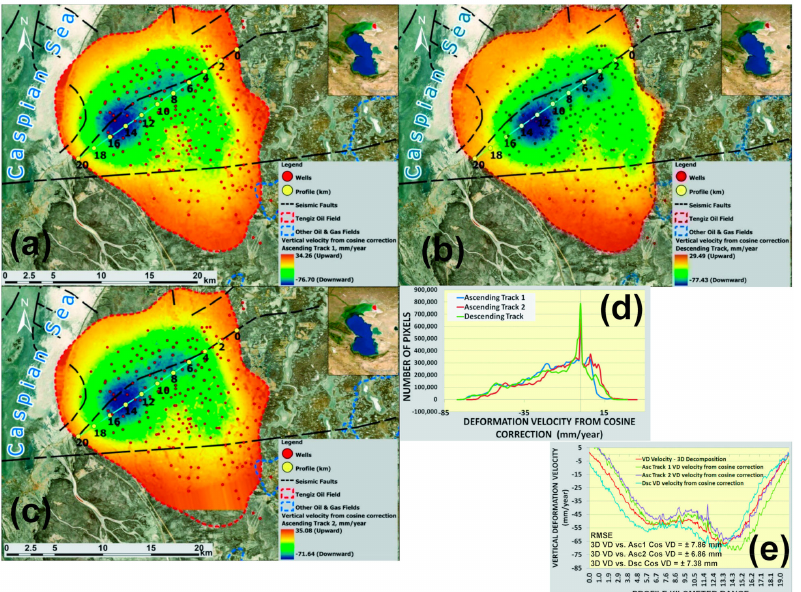
Figure 6. Vertical deformation velocity derived from cosine correction: ( a ) Ascending track 1; ( b ) Descending Track; ( c ) Ascending Track 2; ( d ) histogram of vertical velocity distribution derived from cosine correction; ( e ) comparison of vertical velocity profiles derived from 3D decompositions and cosine corrections.